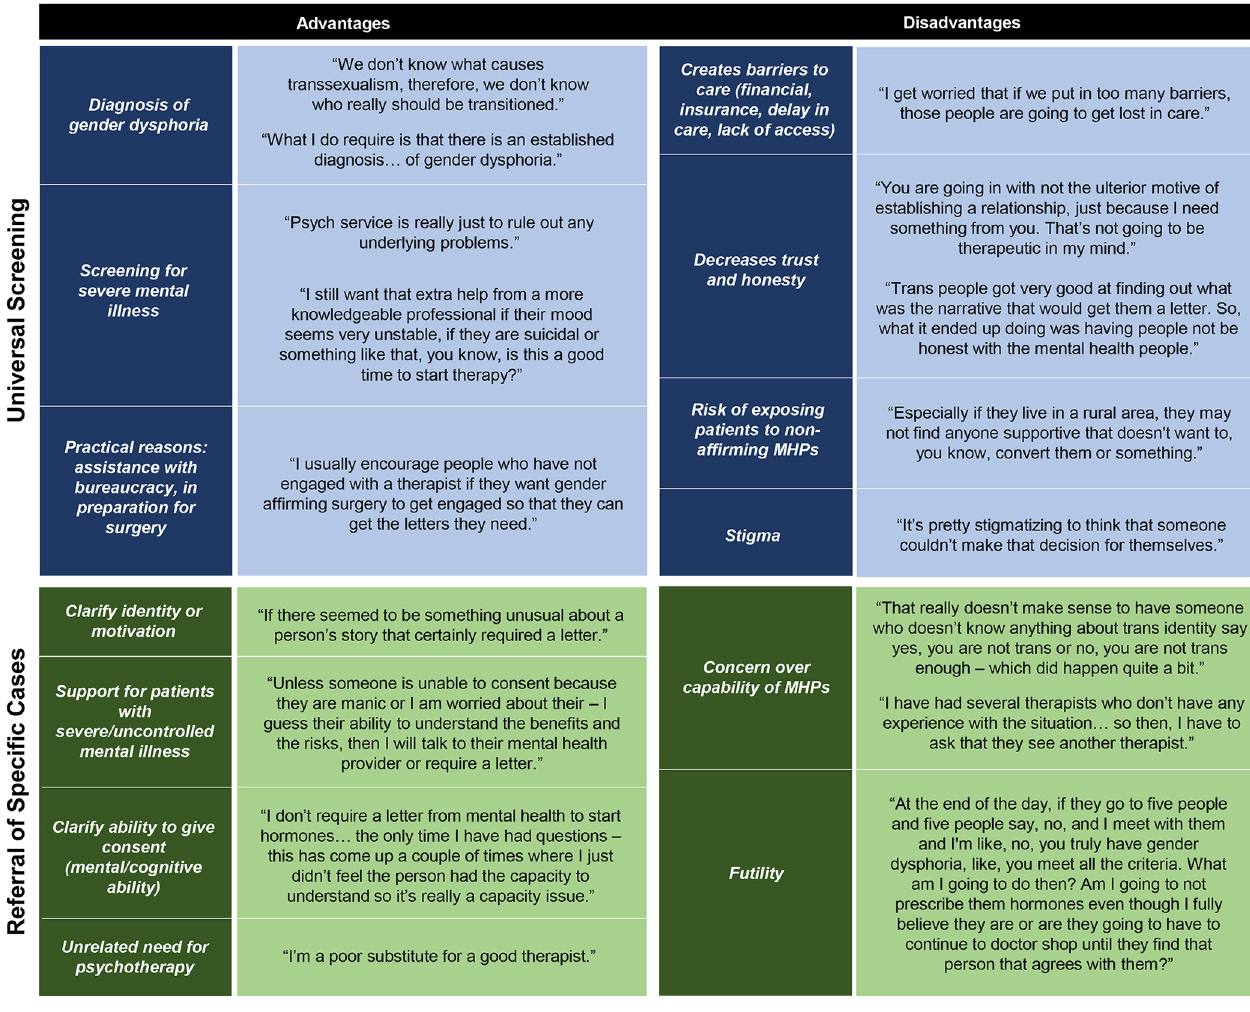
Fig 2. Advantages and disadvantages of involving a mental health provider. MHP, mental health